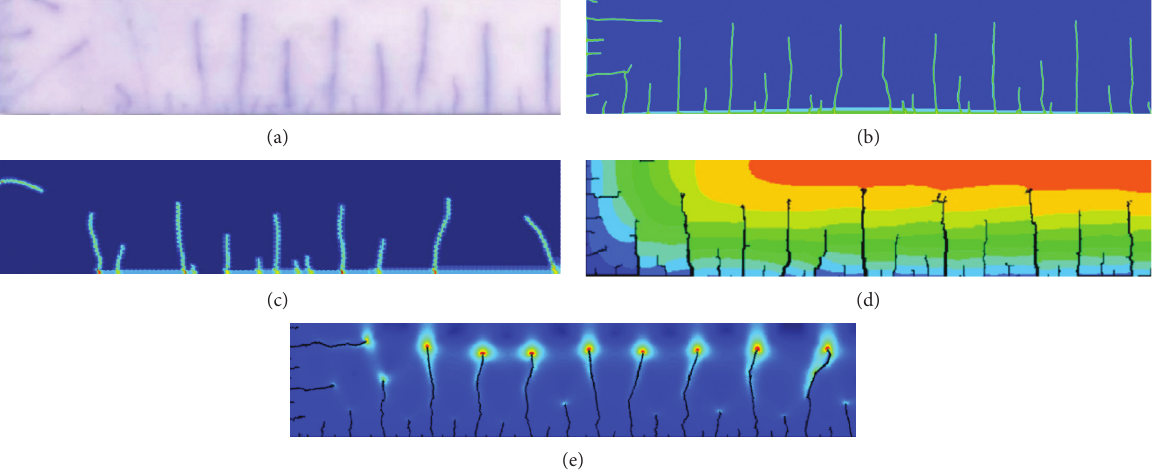
Figure 9: Crack paths predicted by different methods ( T � 600 ° C): (a) experimental result [44]; (b) result of the modified PD model in 0 present work; (c) result of the original PD model [31]; (d) result of FEM [50]; (e) result of nonlocal approach [49].